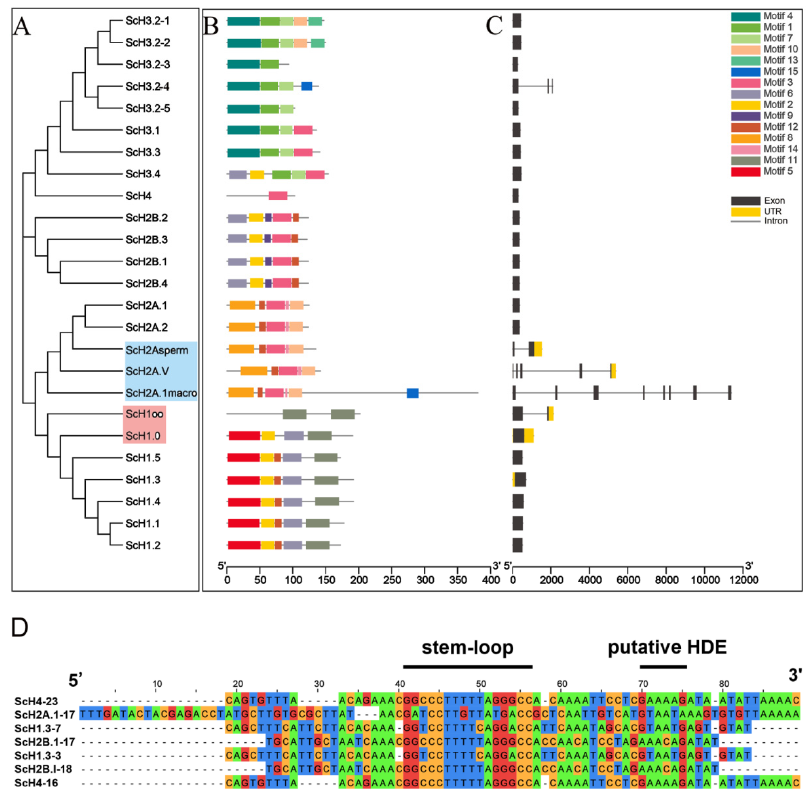
Figure 4. Topology, motif, and gene structure analysis of histone genes in S. constricta . ( A ) The phylogenetic tree was constructed by the MEGA6.0 program using 25 full-length sequences of the different S. constricta histone genes. ( B ) Gene structure analysis of S. constricta histone genes. Untranslated region (UTR), exon, and intron are represented by yellow box, black box, and gray line, respectively. ( C ) Motif analysis of S. constricta histone genes. Different motifs are represented by different color blocks. ( D ) 3 (cid:48) UTR structure of histone genes in S. constricta . Conserved nucleotide sequences of S. constricta histones forming characteristic structural features: stem-loop and histone downstream element (HDE). The number in the gray box is the distance between the stop codon and the first nucleotide of the conserved stem-loop